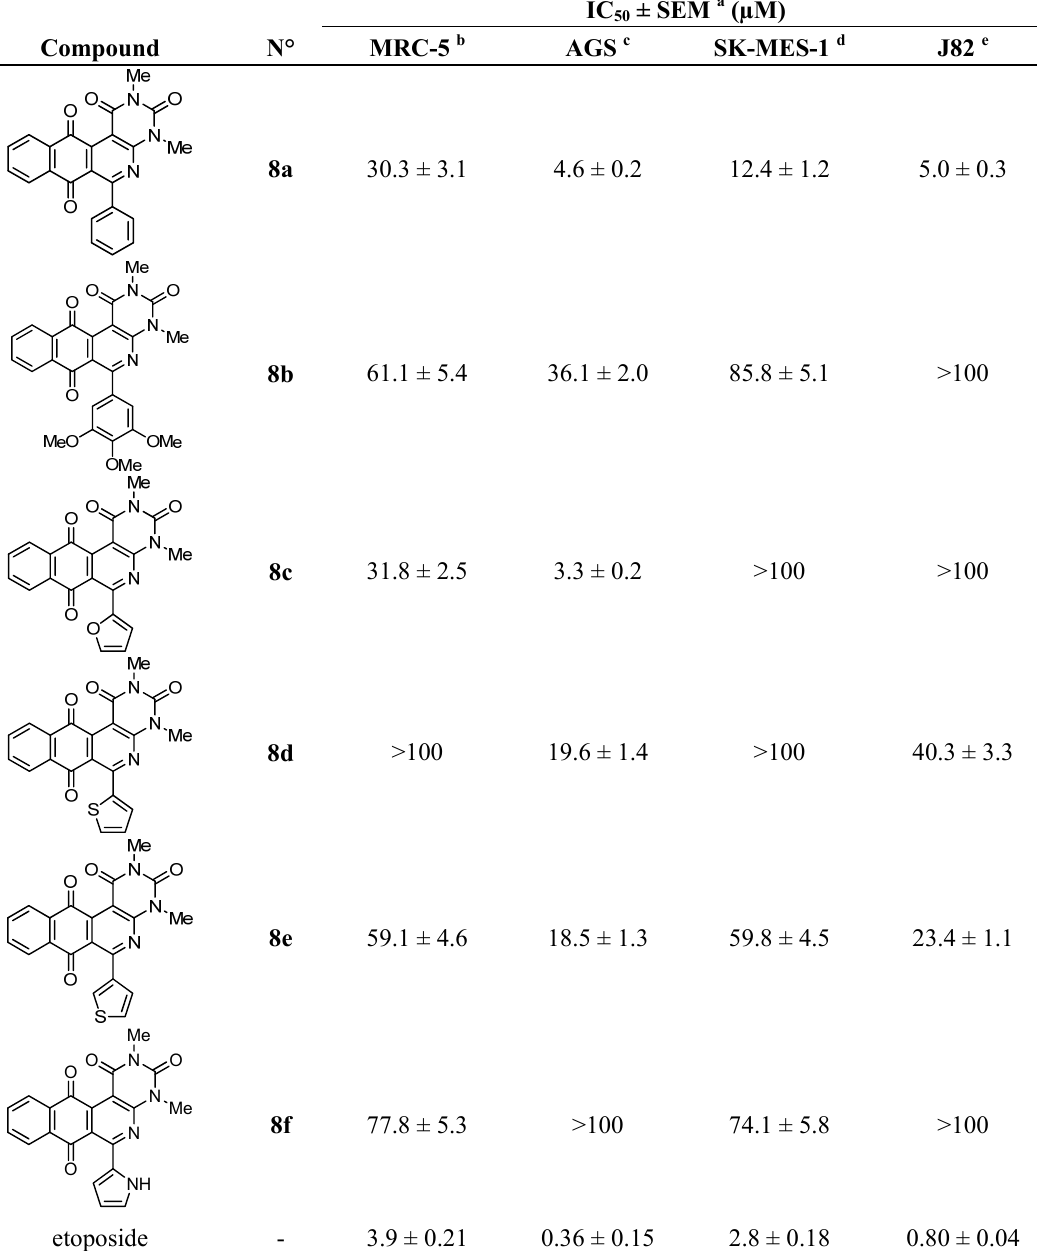
a Data represent mean average values for six independent determinations; b Normal human lung fibroblasts cells; c Human gastric adenocarcinoma cell line; d Human lung cancer cell line; e Human bladder carcinoma cell